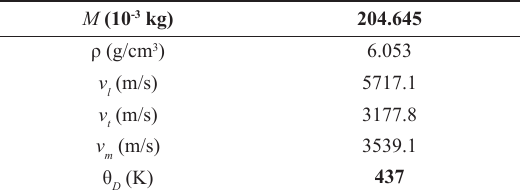
) and average ( v t N 3